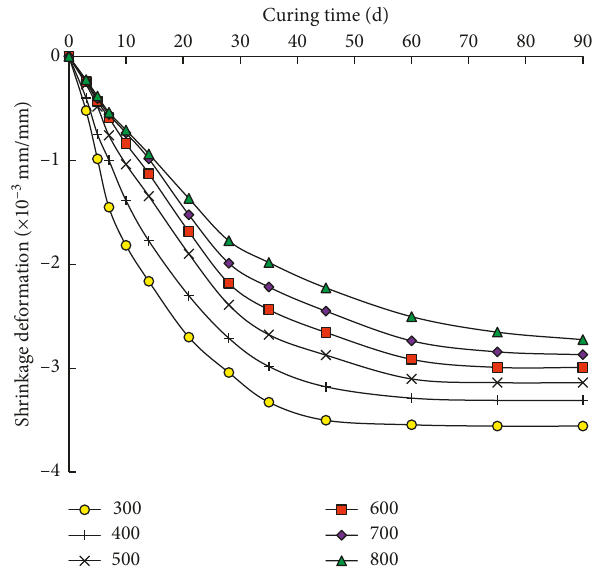
Figure 6: Relationship between shrinkage deformation and curing